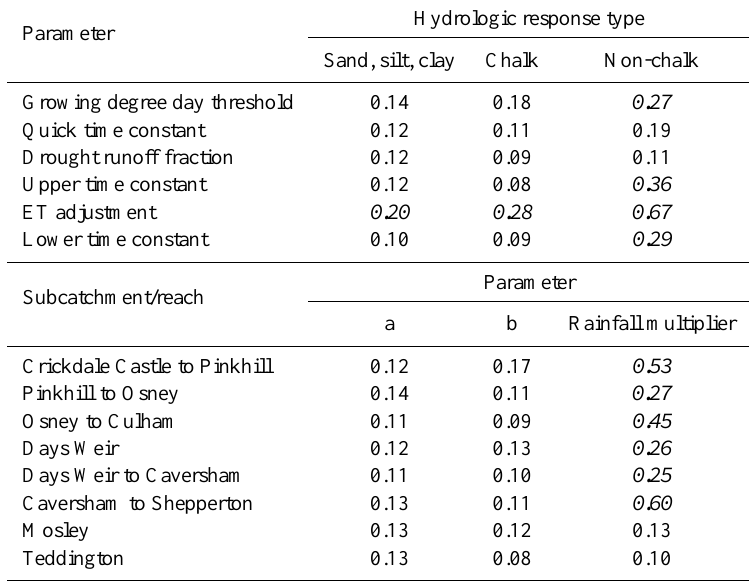
Table 6. Kolmogorov–Smirnov (KS) d statistics showing parameter sensitivity assessed as deviation of posterior parameter distribution from rectangular. Parameters with a significant effect on model performance are shown in italic . Statistical significance has been adjusted to account for multiple comparisons.